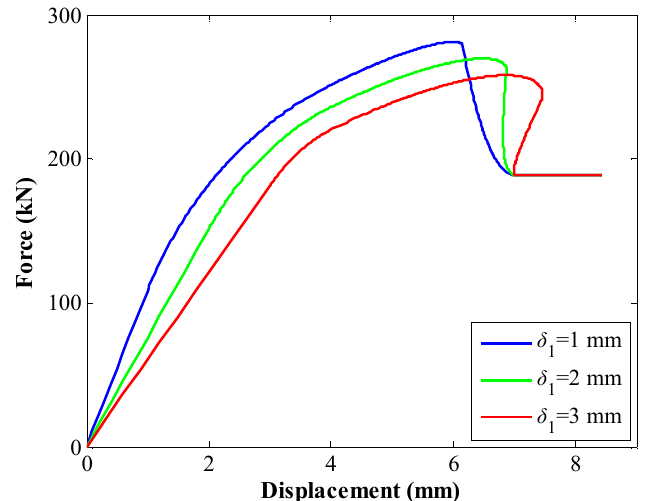
Figure 15. Effect of the bond slip in the bond strength on the load-carrying force of the bars. When the maximum force of the bars was reached, the bond stress at the boundary surface was examined (Figure 16). With the growth of the bond slip in the bond strength, the elastic length and the friction length of the boundary surface gradually grew. For instance, as the bond slip in the bond strength grew from 1 mm to 3 mm, the elastic length of the boundary surface grew from 300 mm to 785 mm. Moreover, the corresponding friction length of the boundary surface grew from 483 mm to 814 mm. The weakening length dramatically declined from 1218 mm to 400